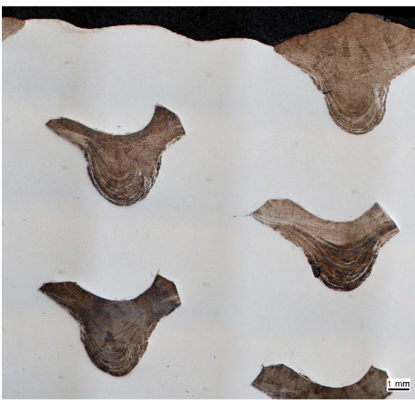
Figure 4. Representation of layer structure in cross section (cutout).